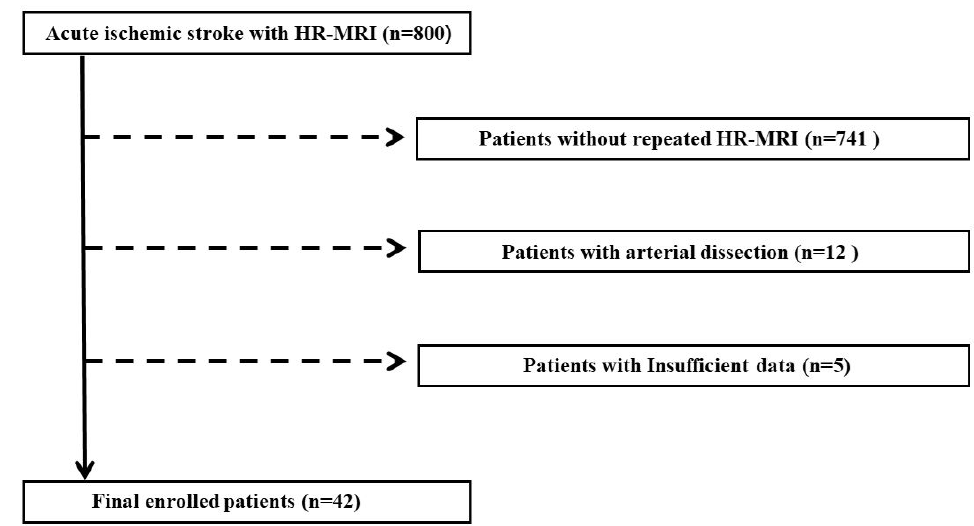
Figure 3. Flowchart of the study population. In total, 800 patients with acute ischemic stroke who had undergone HR-MRI were selected in this study. Analysis of HR-MRI was performed for the cerebral arteries of 59 patients who had undergone repeated HR-MRI. Twelve patients with arterial dissection and five patients with insufficient data were excluded from this study. This study lastly comprised 42 patients with atherosclerosis. HR-MRI, high-resolution magnetic resonance imaging.